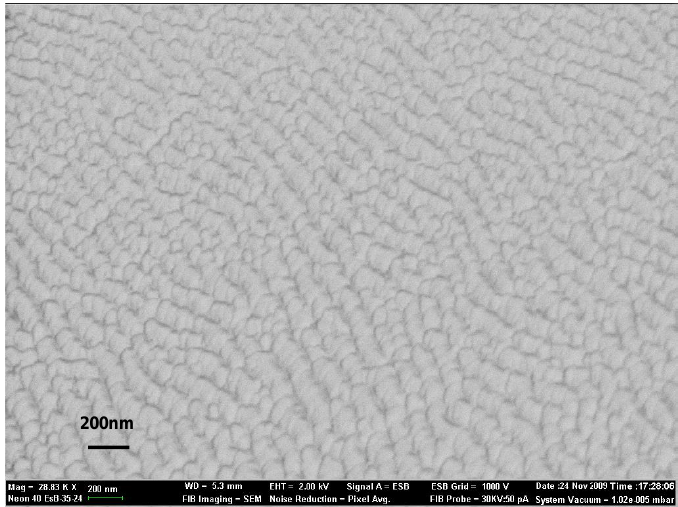
Figure 2. Area of the surface of Cr 56 Al 21 C 23 as-deposited thin film. Rastering effects due to the assisting ion source are revealed by SEM images.